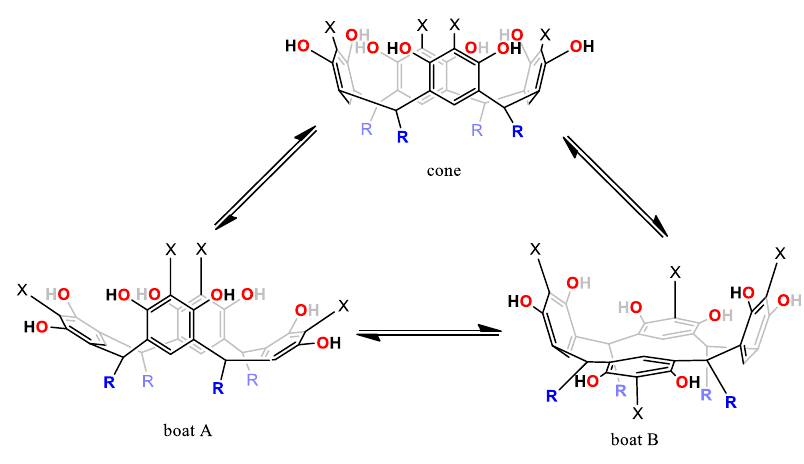
Figure 3. Dynamic behavior of 1a and 2a.